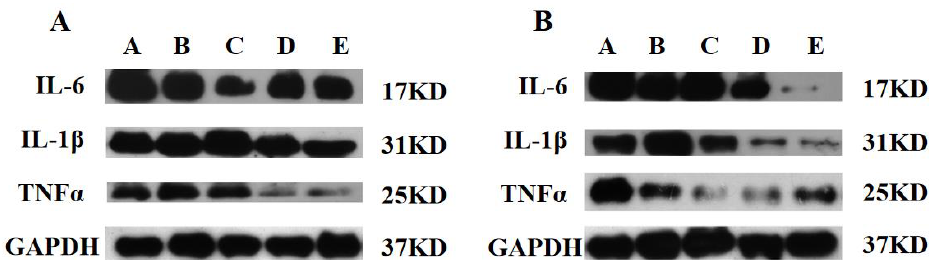
Figure 8. Western blot analysis of IL-6, IL-1 β and TNF- α at ( A ) 7 days and ( B ) 14 days (A: Control, B: Aquacel Ag, C: ODEX/HA-ADH, D: ODEX/HA-ADH/HACC, E: Ag@ODEX/HA-ADH).